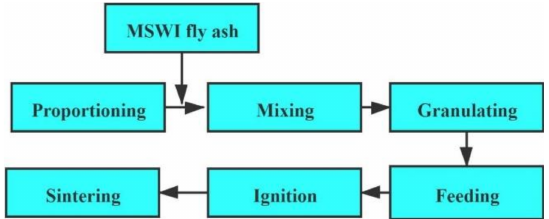
Figure 2. Flow diagram of co-disposing MSWI fly ash through iron ore sintering. Developed from